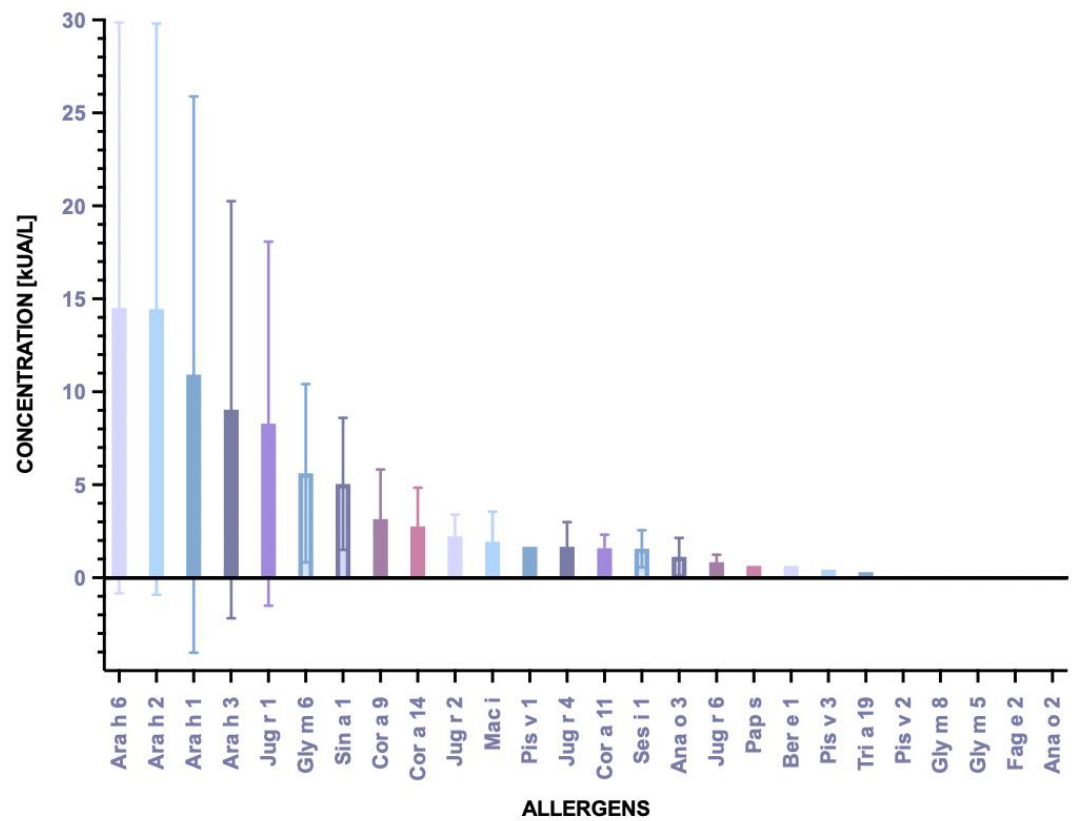
Figure 3. Values of sIgE concentration for 26 storage proteins.